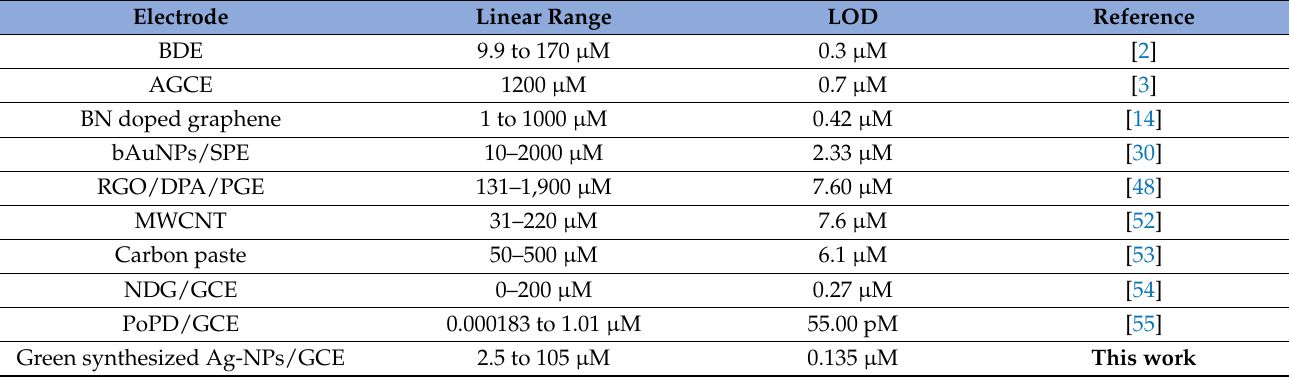
Figure 12. ( a ) Typical steady state amperometric measurement of nicotine oxidation at 1.0 V (vs. Ag/AgCl) with successive additions of nicotine from 2.5 to 105 µ M in 0.1 M PBS. ( b ) Calibration curve of NIC which was made by I pa vs. [NIC]. Table 2. Comparison of various analytical parameters between the proposed method and other reported EC sensors for NIC.